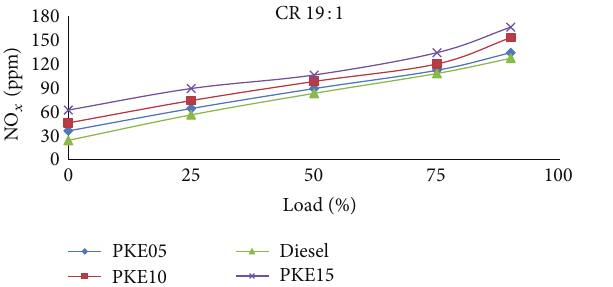
Figure 20: Load versus SO 𝑥 emissions at 16.5 :1 CR.